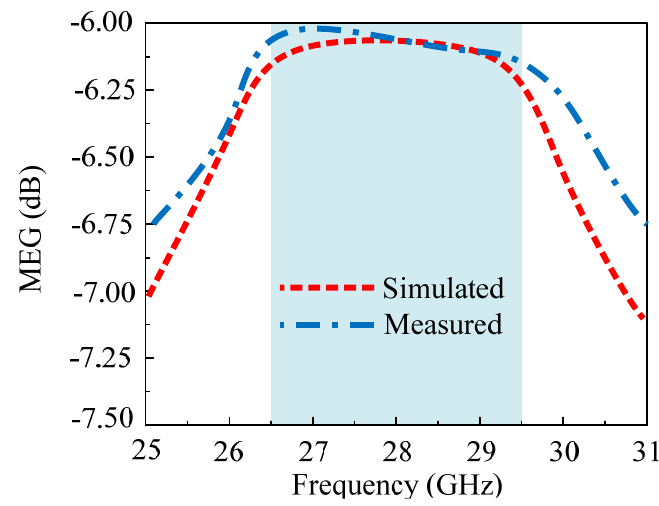
Figure 15. Simulated and measured MEG of the proposed antenna.